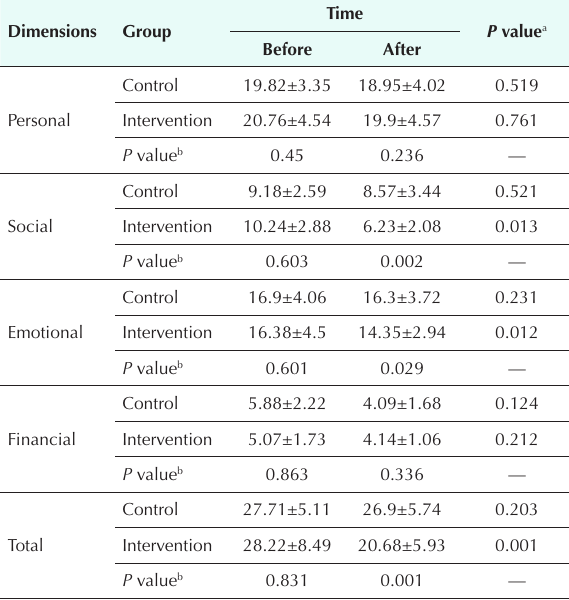
Table 3. Within- and between-group comparisons with respect to the mean scores of burnout and its dimensions